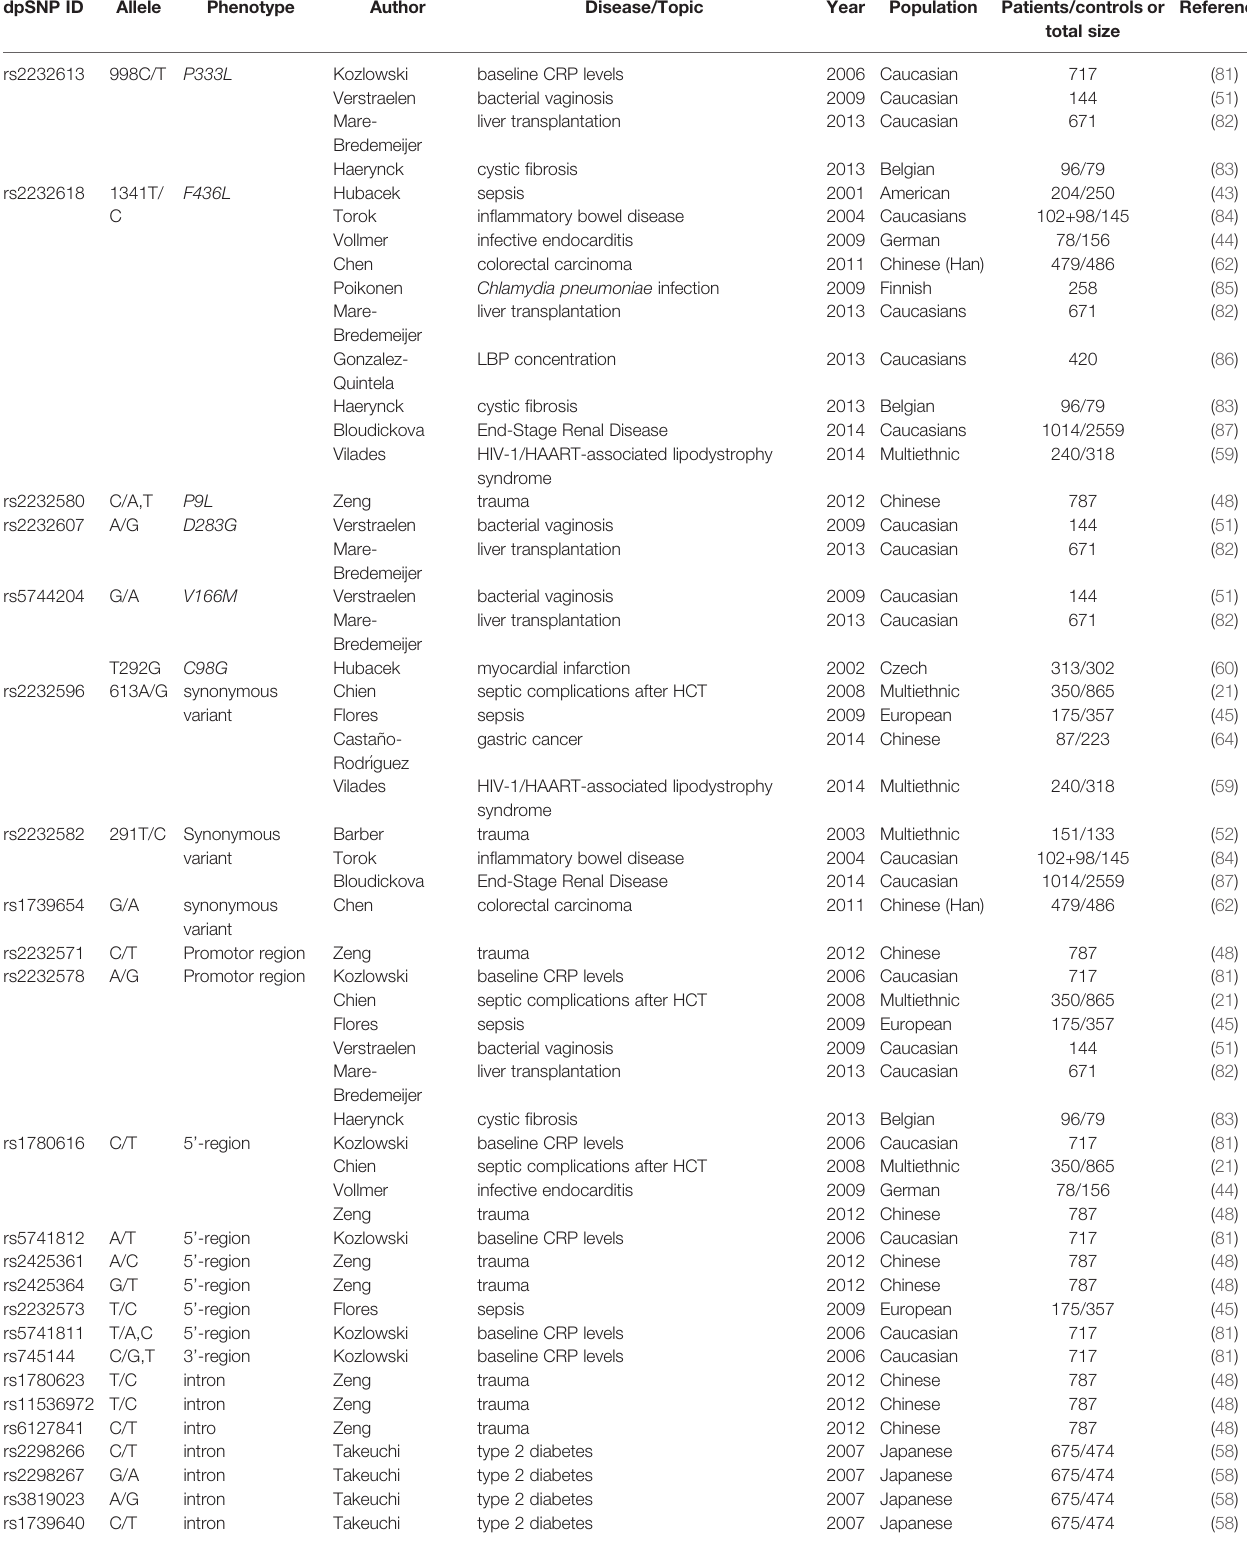
TABLE 4 | Summary of Lipopolysaccharide Binding Protein (LBP) SNPs not associated with corresponding